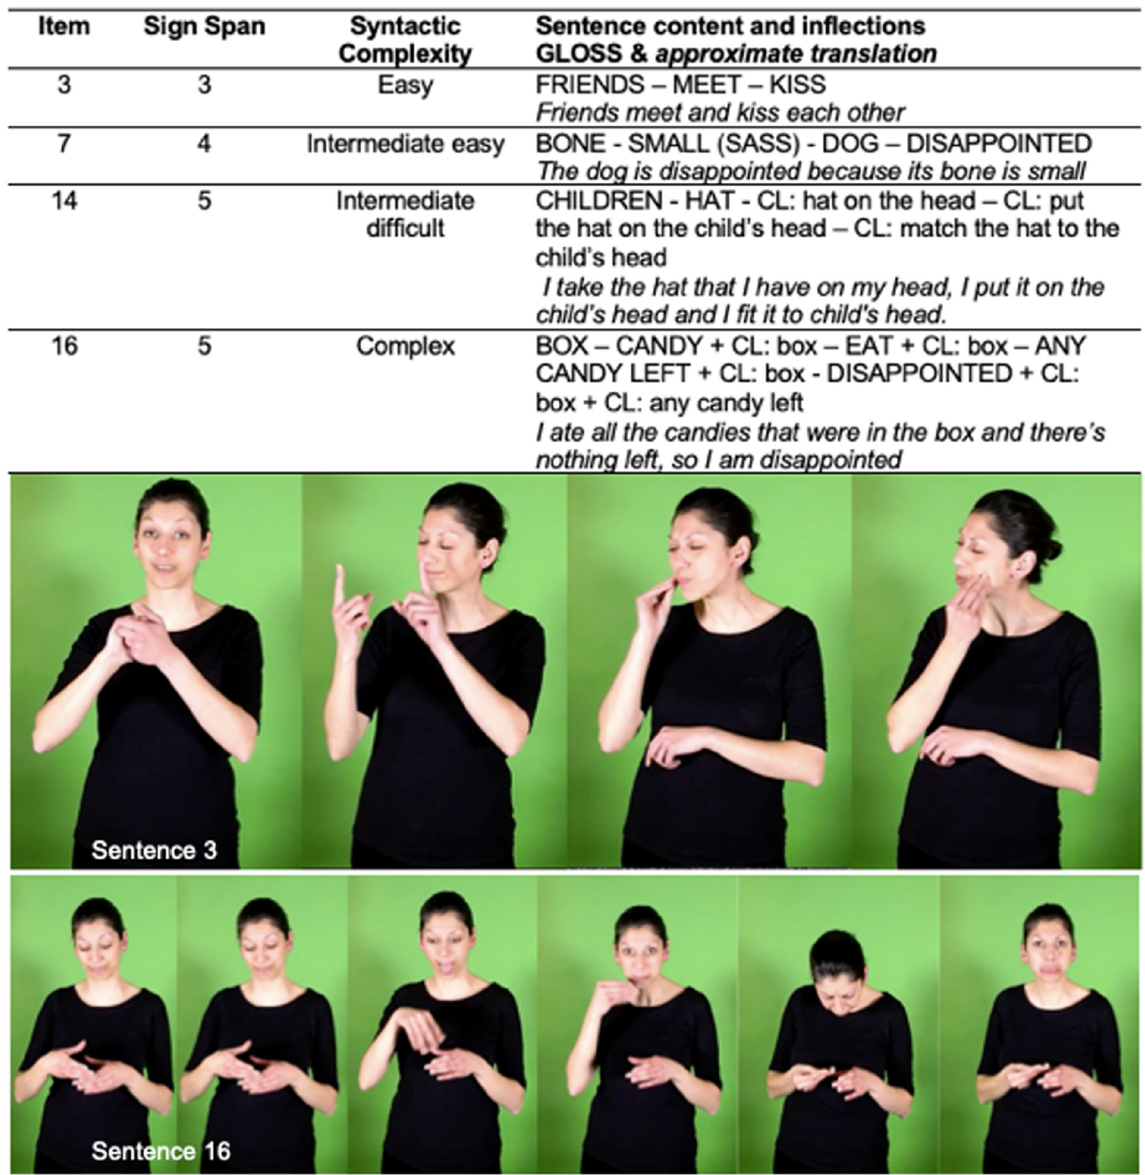
Fig 1. Sentences with four levels of complexity. Sentences of each level of syntactic complexity were presented in the Supporting Information (S1 Video: easy sentence; S2 Video: intermediate easy sentence; S3 Video: intermediate difficult sentence; S4 Video: complex sentence). All the sentences presented in the SRT are listed in the (S1